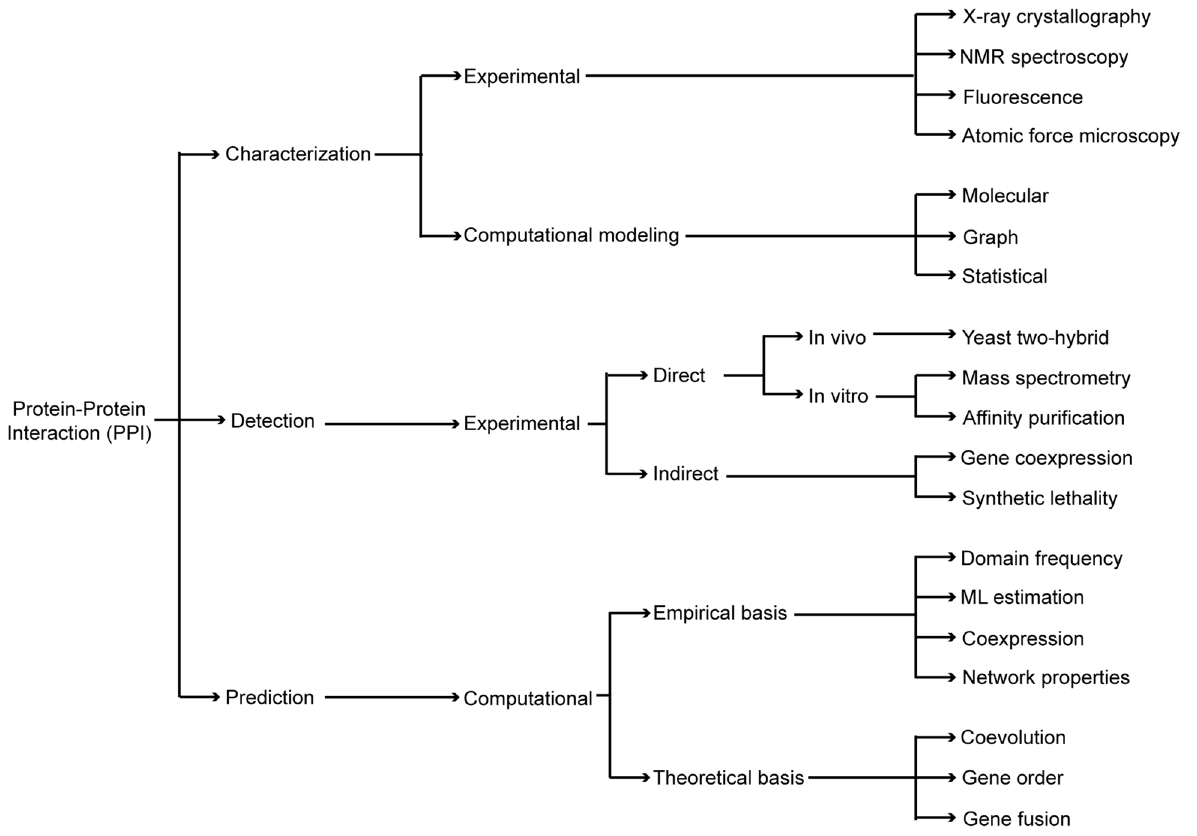
Figure 2. A diagram of the different experimental and computational methods to characterize, detect, and predict PPIs.